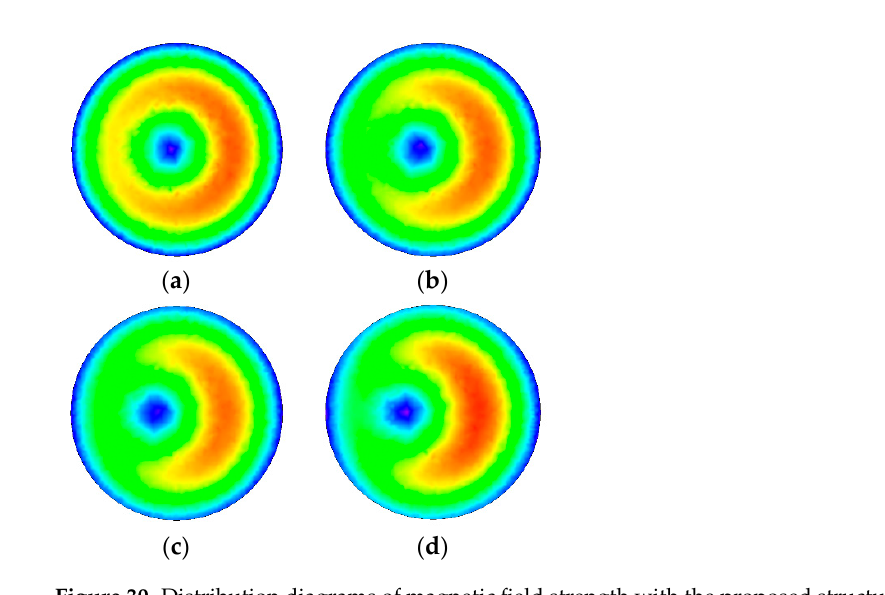
ferent offsets of the secondary coil. ( a ) 5 mm. ( b ) 10 mm. ( c ) 15 mm. ( d ) 20 mm.